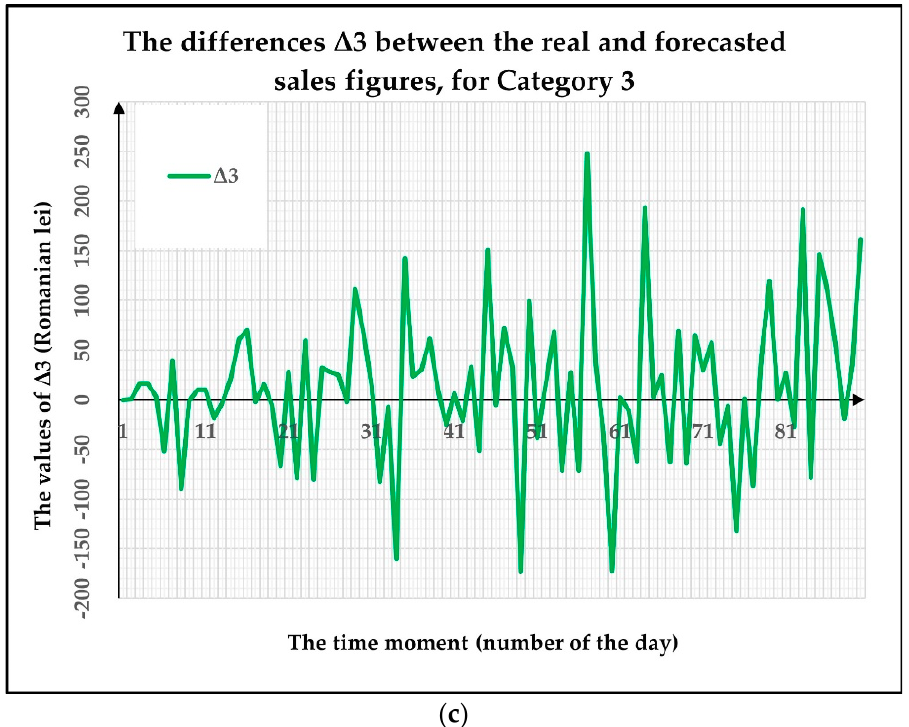
Figure 5. The differences between the real and forecasted category product sales for the 3 product categories of the e-commerce store. ( a ) The differences between the real and forecasted product sales, for Category 1. ( b ) The differences between the real and forecasted product sales, for Category 2. ( c ) The differences between the real and forecasted product sales, for Category 3.